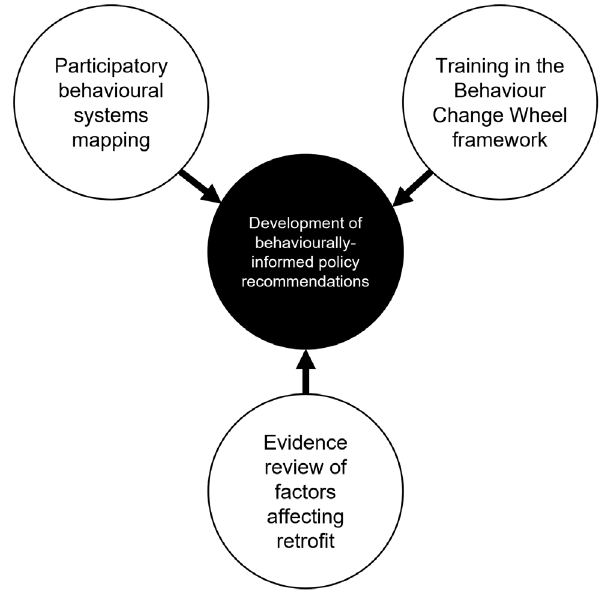
Figure 1 Approach to developing behaviourally- informed policy